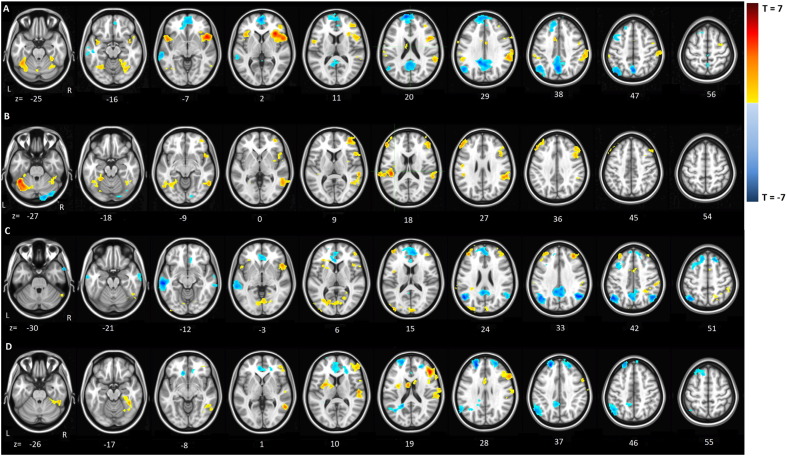
Functional connectivity patterns from the inferior frontal seed node, during successful stop condition (A) and failed stop condition (B); and functional connectivity from the superior frontal seed node, during successful stop condition (C) and failed stop condition (D). Red/yellow hues indicate positive connectivity values; blue hues indicate negative connectivity values.